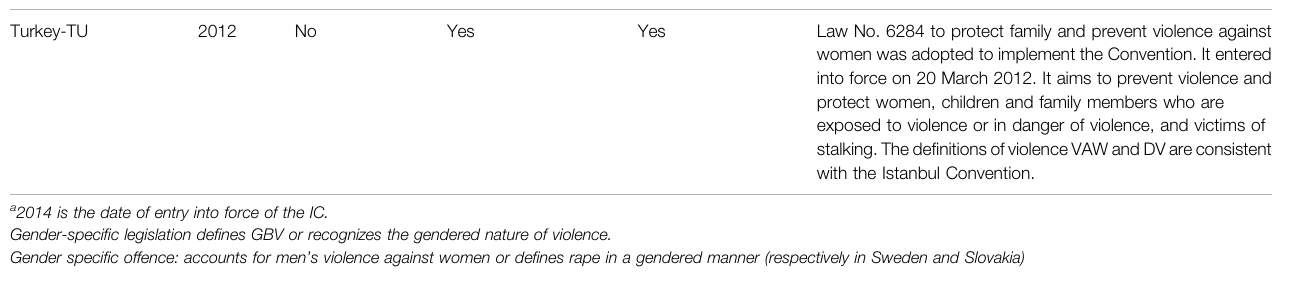
TABLE 2 | Overview of criminalization of domestic violence and speci fi c forms of VAW. Country/country